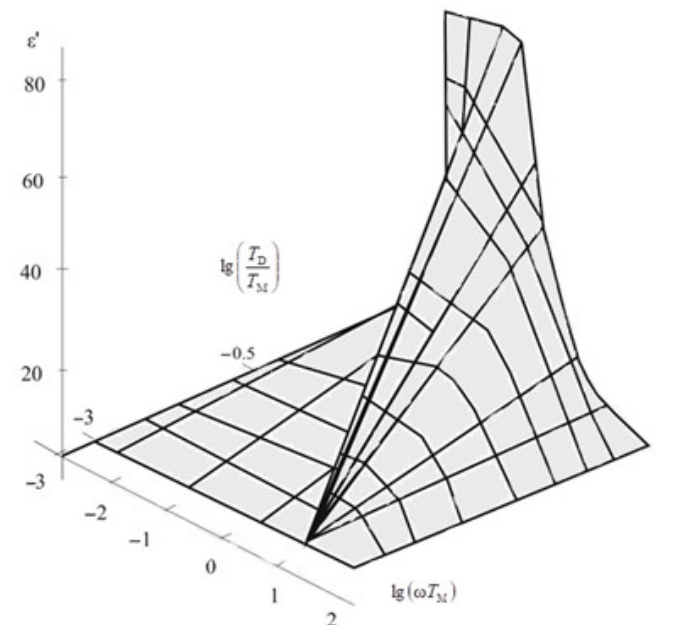
(cid:104) (cid:16) (cid:17)(cid:105) / T D ˆ ε ( ω ) ; ω T M on dimensionless T M M and α 2 = ω T M T M